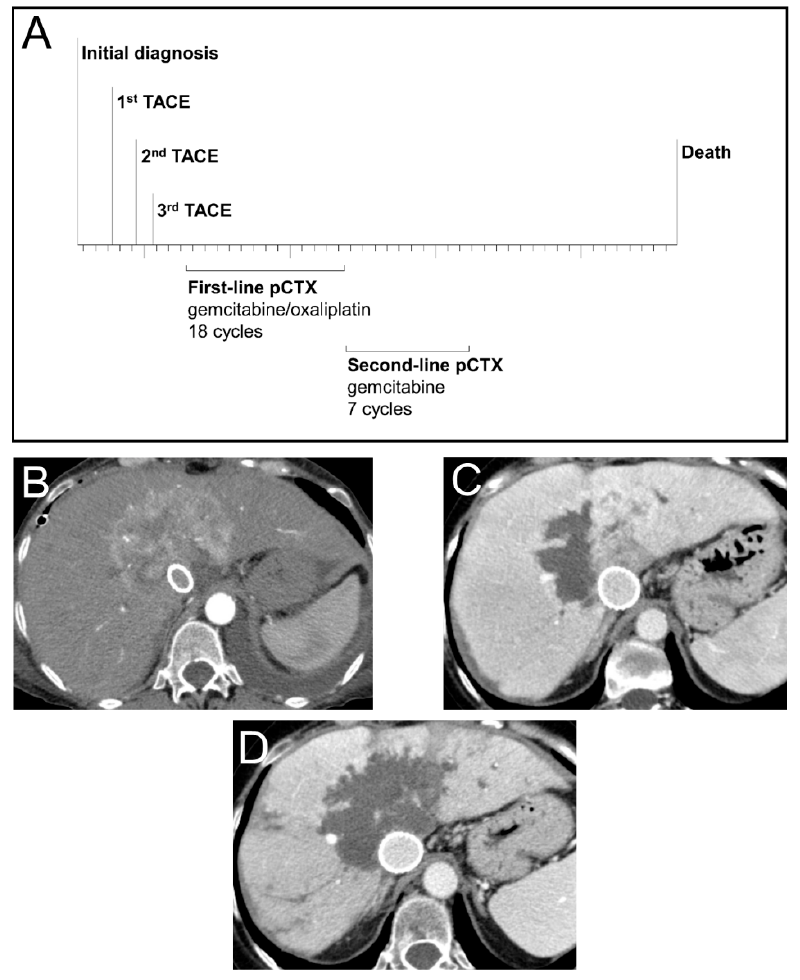
Figure 3. Treatment, survival and radiological response of a patient with advanced iCCA. ( A ) Time- line of sequential treatment with transarterial chemoembolization (TACE) and palliative chemo- therapy (pCTX) in a 53-year-old female patient diagnosed with a centrally localized iCCA. ( B ) CT scan (arterial phase, axial) prior to first TACE treatment showing a hypervascularized large central iCCA. Due to a vena cava compression syndrome, a cava stent was implanted. ( C ) CT scan (venous phase, axial) after the first TACE treatment of the right tumour part indicating partial devascularization. ( D ) CT scan (venous phase, axial) after the third and last TACE treatment showing devascularization of the iCCA with only minimal residual tumor.